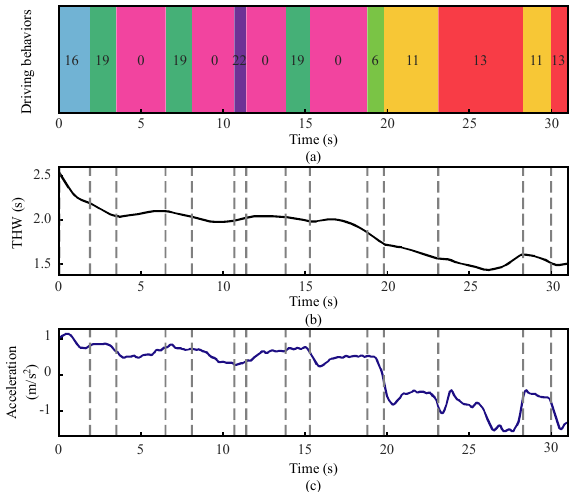
Figure 11. The segmentation results of the driving behavior of driver #5 in one following event, ( a ) the sequence clusters of the driving behavior, ( b ) the fragments result of THW, ( c ) the fragments result of acceleration.